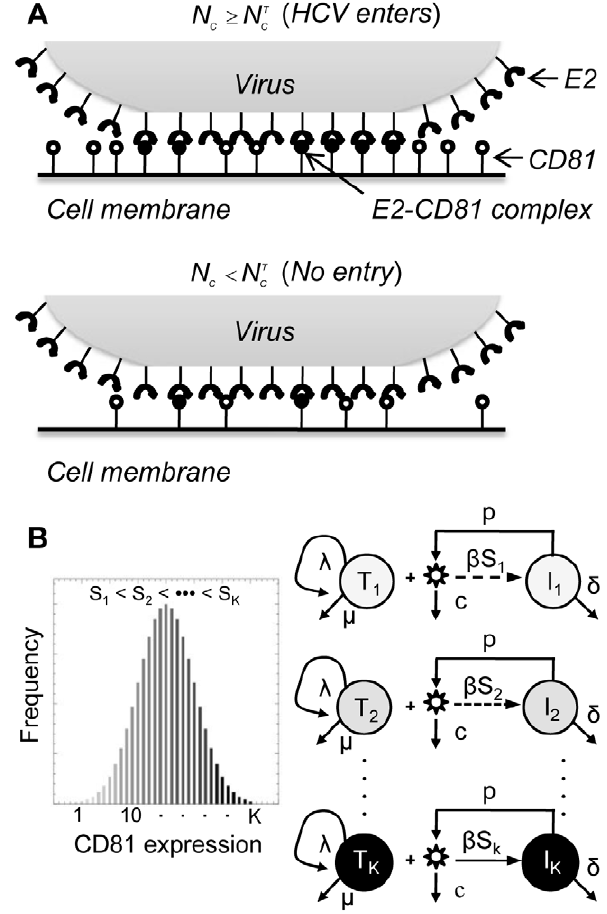
Figure 1. Schematic of the model. (A) HCV enters a target cell if the number of E2-CD81 complexes formed across the virus-cell pair, N C , (top), but not otherwise (bottom). (B) Viral exceeds the threshold, N T C kinetics following the exposure of cells with a distribution of the CD81 expression level (left) to virions in vitro is determined by the time- evolution of subpopulations 1 through K of cells with distinct CD81 expression levels and hence different susceptibilities to HCV entry